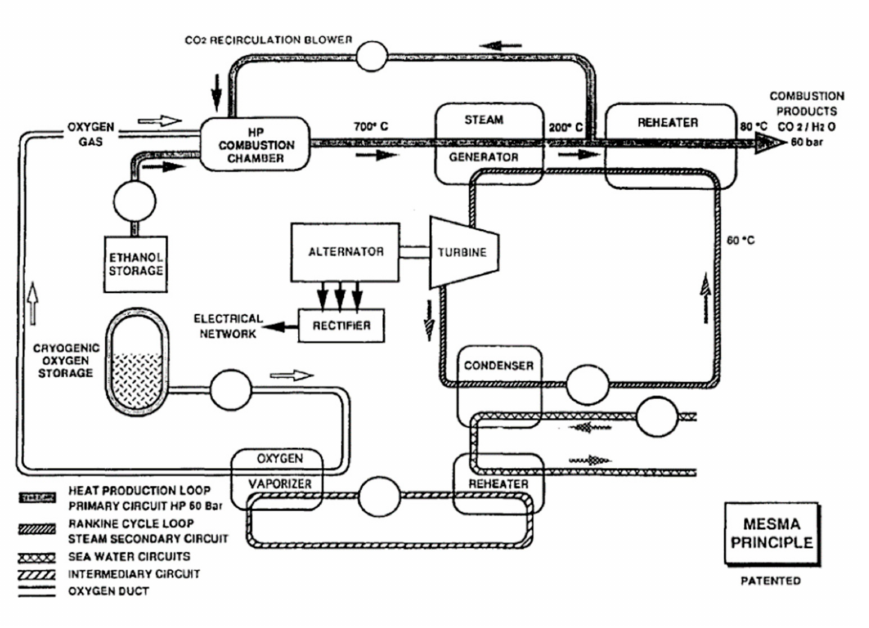
Figure 12. MESMA Schematic